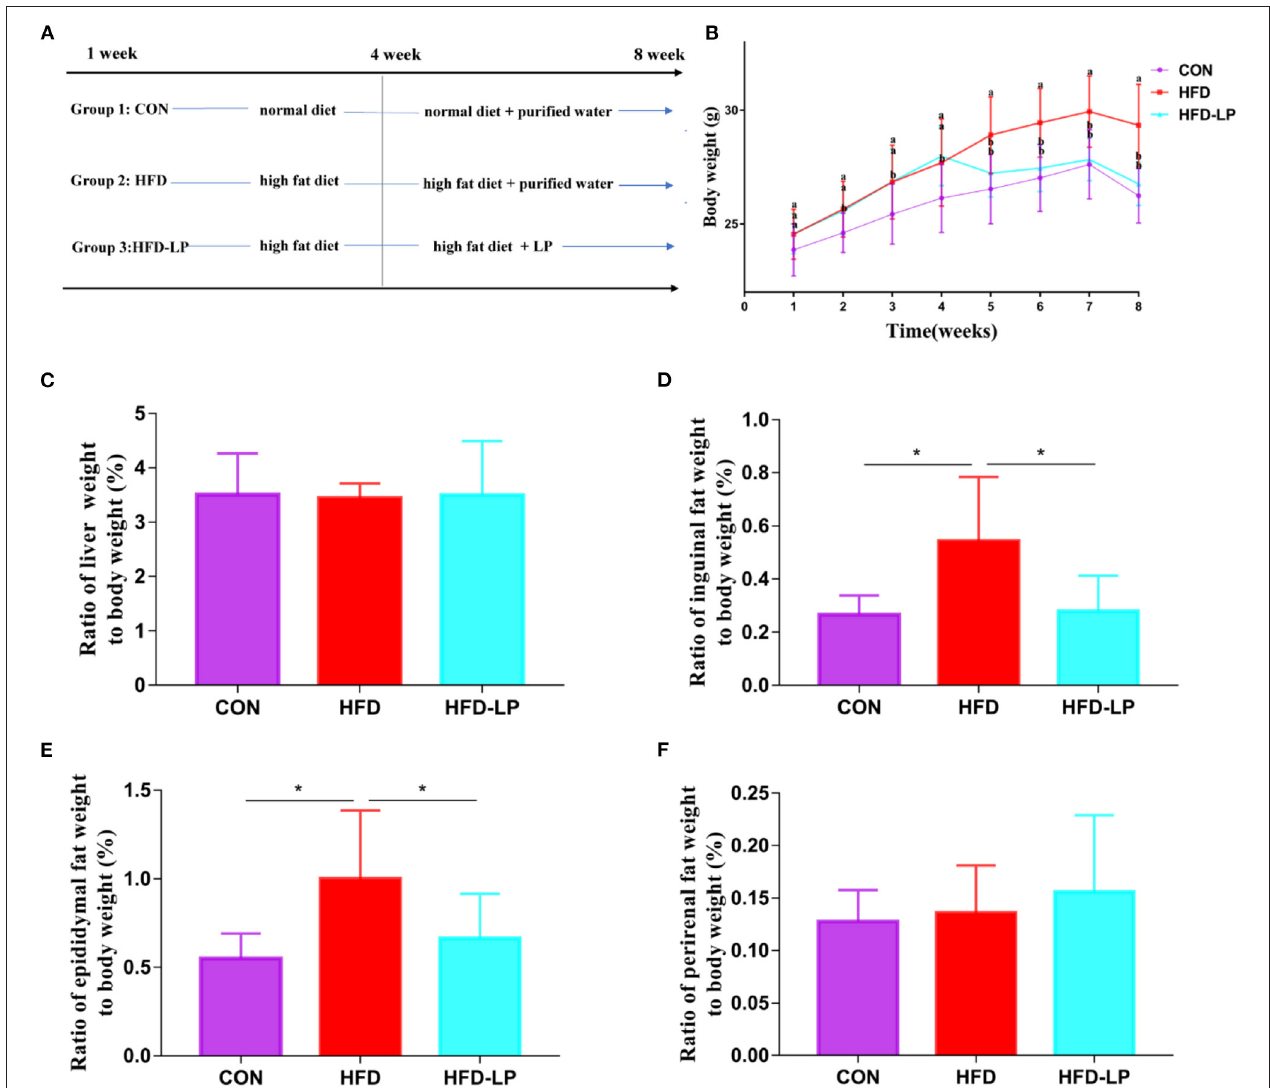
FIGURE 1 | Effect of Lactobacillus plantarum on body weight, fat and internal organs of obese mice. (A) the experimental process; (B) the body weight; (C) the ratio of liver weight to body weight; (D) the ratio of Inguinal fat weight to body weight; (E) the ratio of Epididymis fat weight to body weight; (F) the ratio of perirenal fat weight to body weight. Data are mean ± SD ( n = 8) and analyzed by one-way ANOVA. * p <